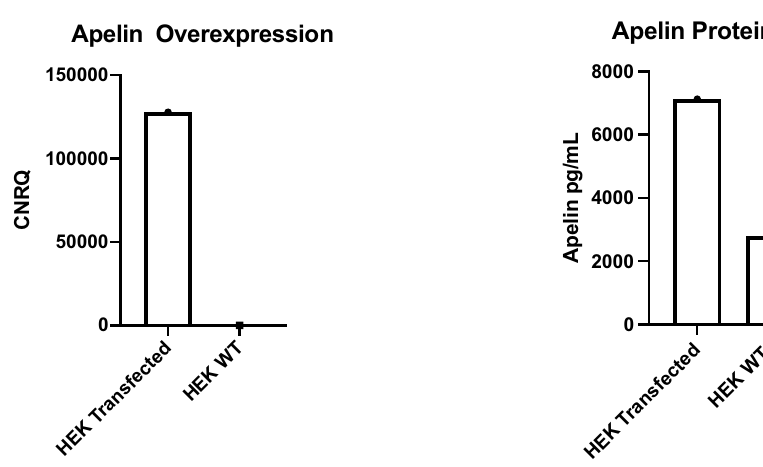
Figure 4. Left: Transfection of HEK293 cells with human preproapelin cDNA confirmed by qPCR. Right: apelin-36 levels in HEK WT and HEK transfected as measured with